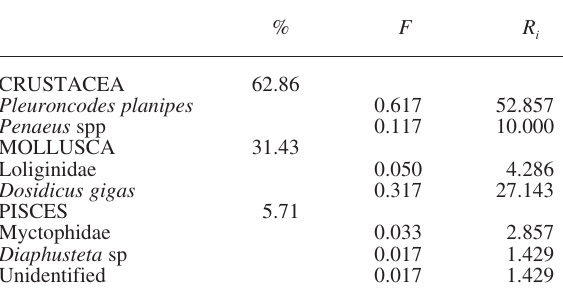
index of numerical